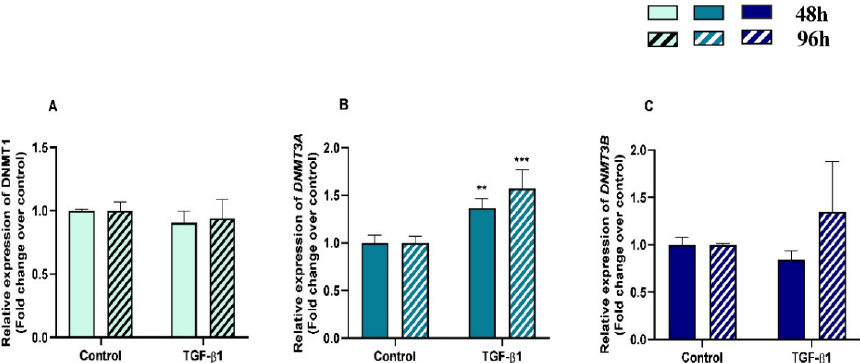
Figure 3. Relative DNA methyltransferases (( A )— DNMT1 , ( B )— DNMT3A , and ( C )— DNMT3B ) mRNA levels in mare endometrial fibroblasts after incubation with TGF- β 1 (10 ng/mL) for 48 h and 96 h; n = 5. All values are expressed as percentage of change from respective hour control (non-treated fibroblasts). Bars represent mean ± SEM. Asterisks indicate significant differences from the respective control (** p < 0.01, *** p < 0.001).